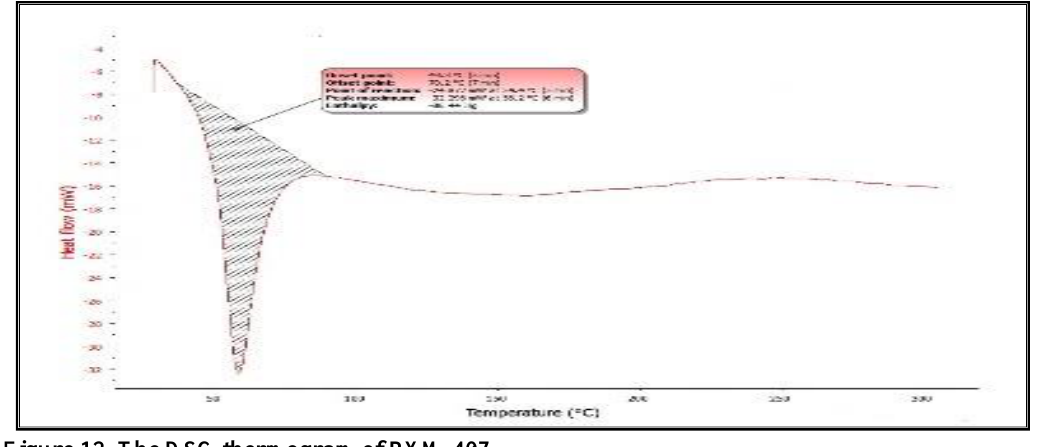
Figure 12. The DSC thermogram of PXM 407